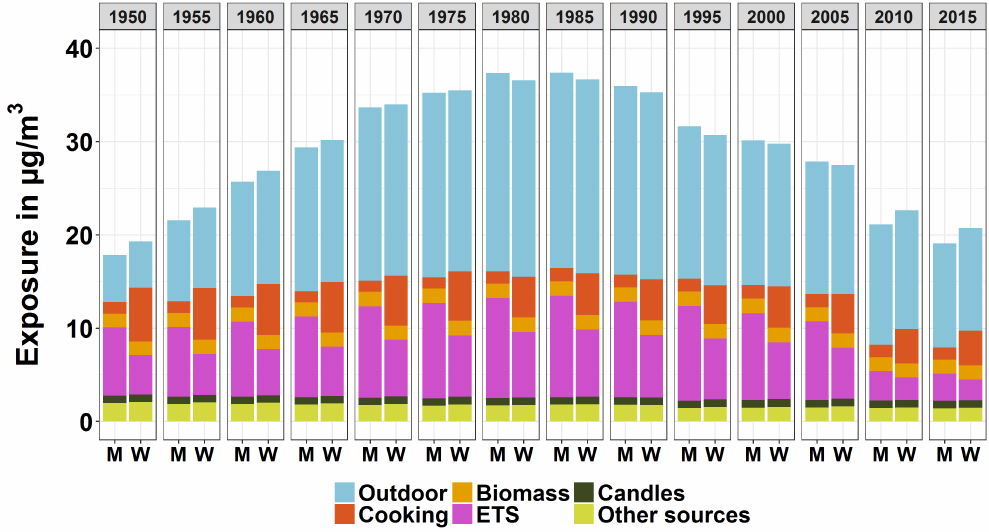
Figure 4. Population-weighted arithmetic mean PM 2.5 exposure by source and gender for European countries from 1950 to 2015. The “M” stands for “Men” and “W” stands for